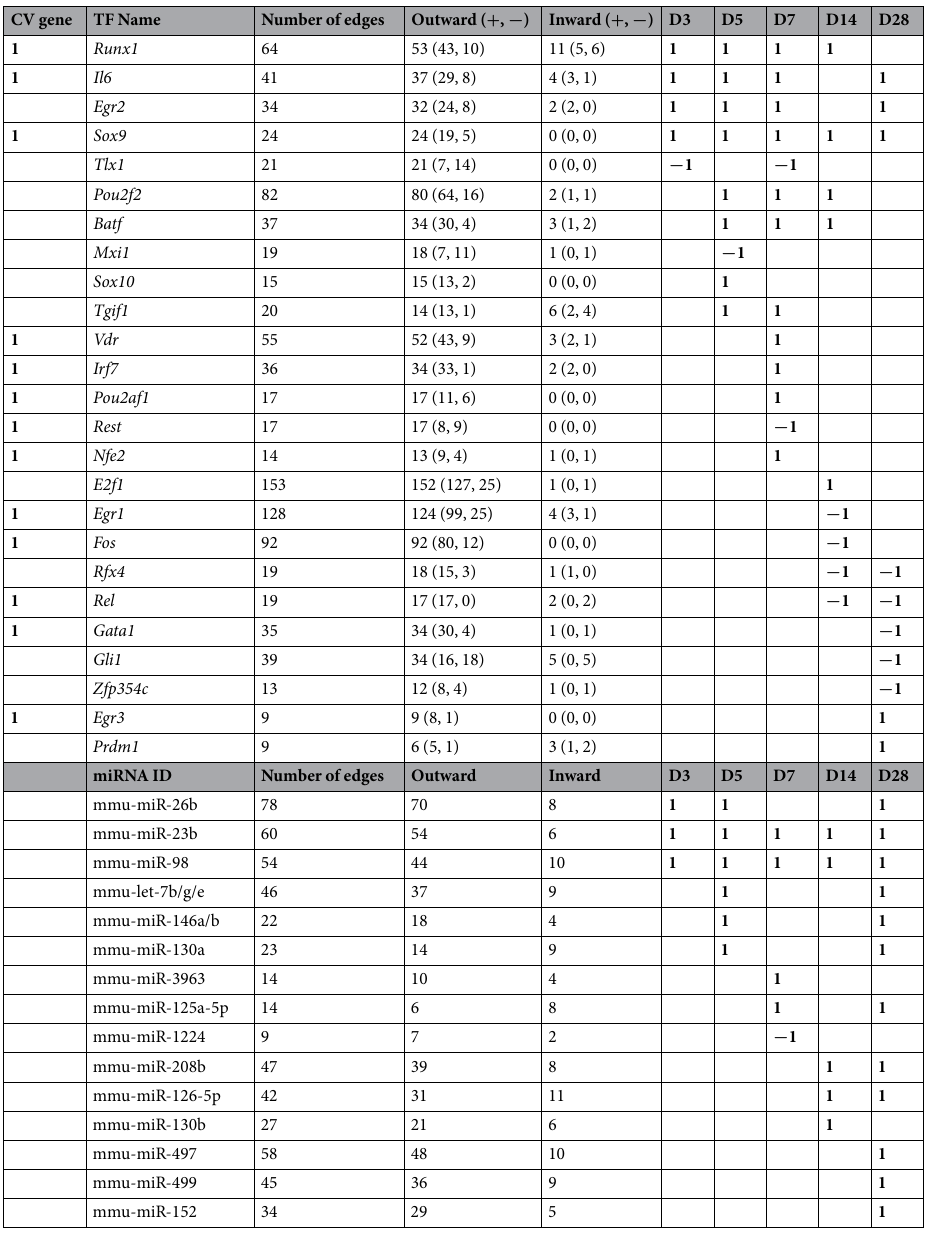
Table 1. List of hubs in TAB-preferential regulatory network for each time point. (A) Top 5 TF genes (upper table) and (B) Top 3 miRNAs (lower table) with highest total degrees that first emerged at each time point. The values 1 and − 1 in the five right most columns represent up- and down-regulated differential expression, respectively, from day 3 to day